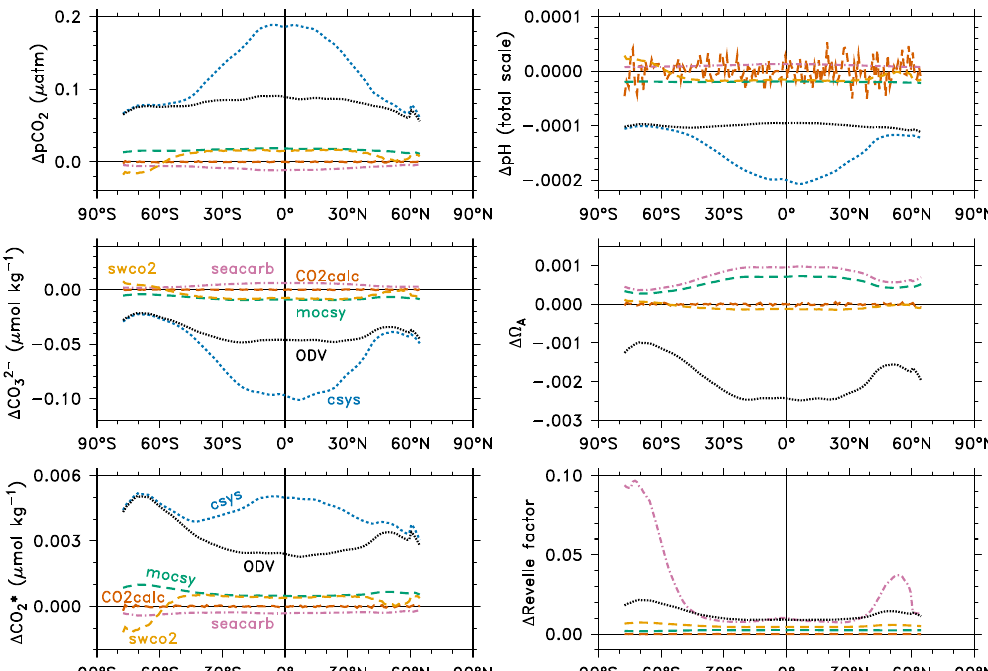
Figure 2. Global zonal-mean surface values for variables computed from gridded data products for A T and C T from GLODAP (Key et al., 2004) combined with T , S , and nutrients from the 2009 World Ocean Atlas (WOA2009) (Locarnini et al., 2010; Antonov et al., 2010; Garcia et al., 2010). Curves are shown for each package and variable after subtracting off corresponding results for the CO2SYS-MATLAB reference. The csys package does not provide results for (cid:127) A and the Revelle factor. It also neglects nutrient alkalinity, but its curves were adjusted to include the effects of P T and Si T as computed by mocsy.